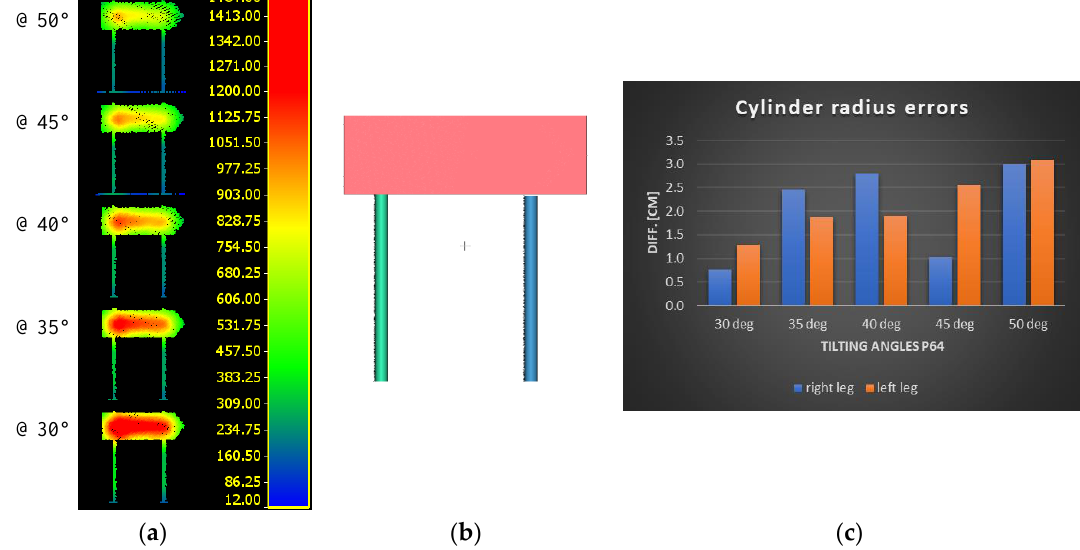
Figure 19. ( a ) Density of points at the road board sign at each tilting angle (red ≥ 1200 pts/m 2 ). ( b ) An example of the detected primitives of the board sign. ( c ) Histogram of differences in the estimated cylindrical board legs radii.